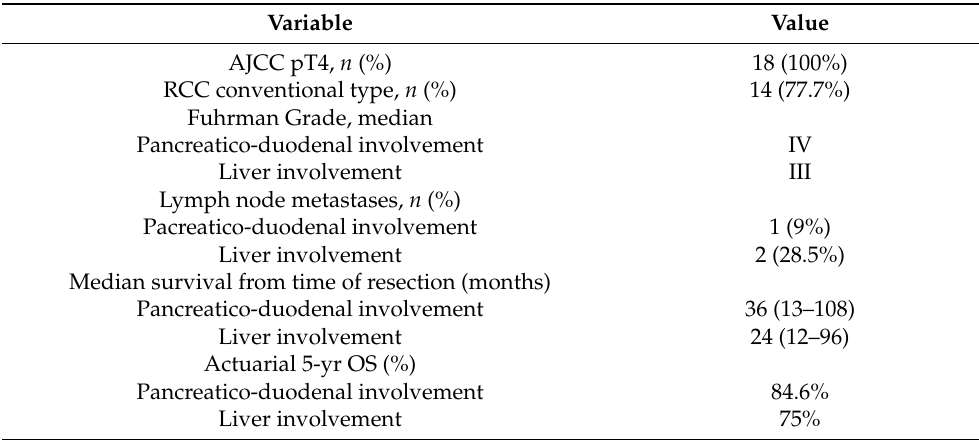
Table 4. Pathological characteristics and survival